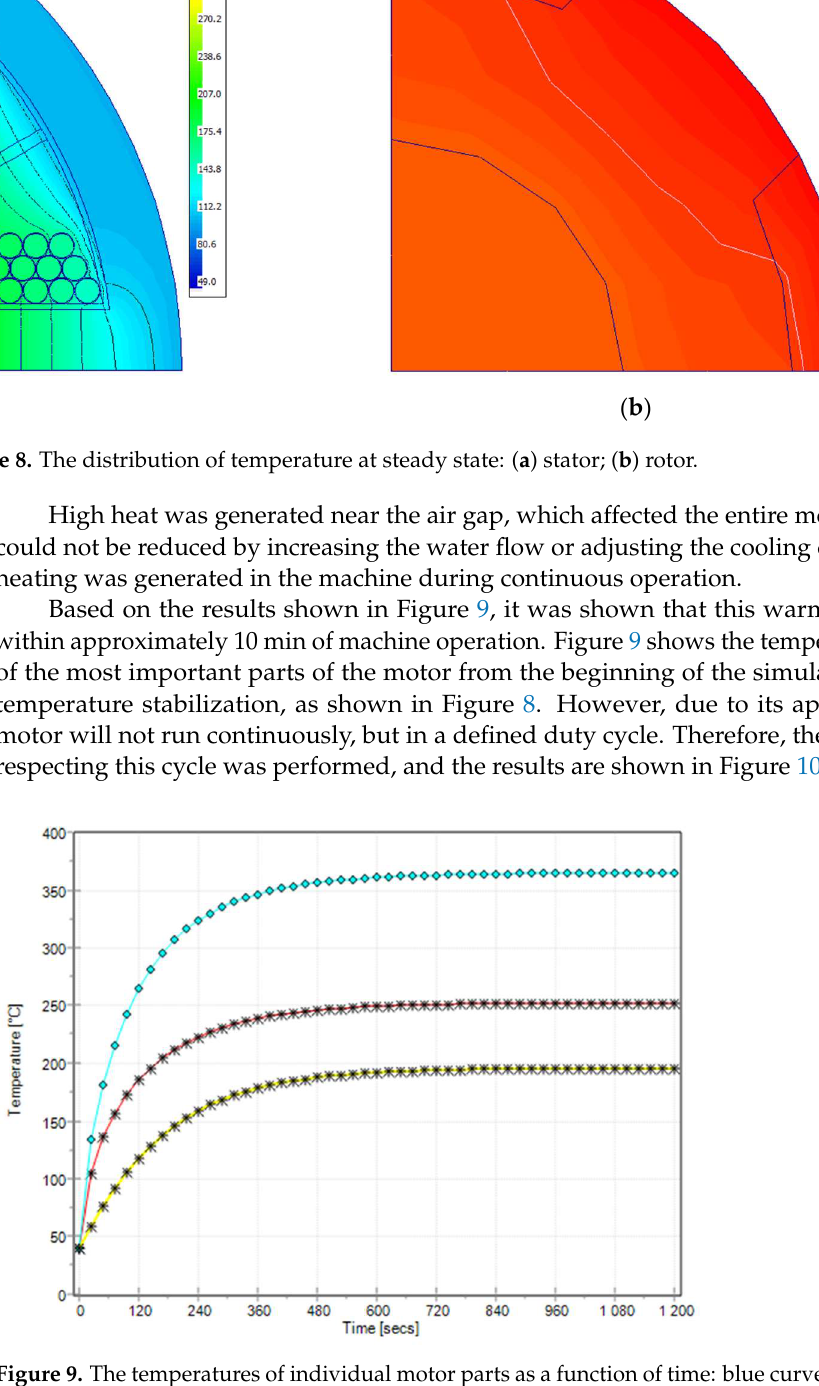
( b ) Figure 10. The distribution of temperature at steady state with duty cycle: ( a ) stator; ( b ) rotor. The implementation of the motor duty cycle improved cooling and significantly re- duced the temperature. However, the rotor was still heated to 172.1 °C, which was more than the limit of the sheet. The stator and rotor sheets had a temperature limit of 150 °C. Therefore, it was necessary to reduce the rotor diameter to reach this limit. This analysis is presented in the following section. 4.4. Rotor Optimization